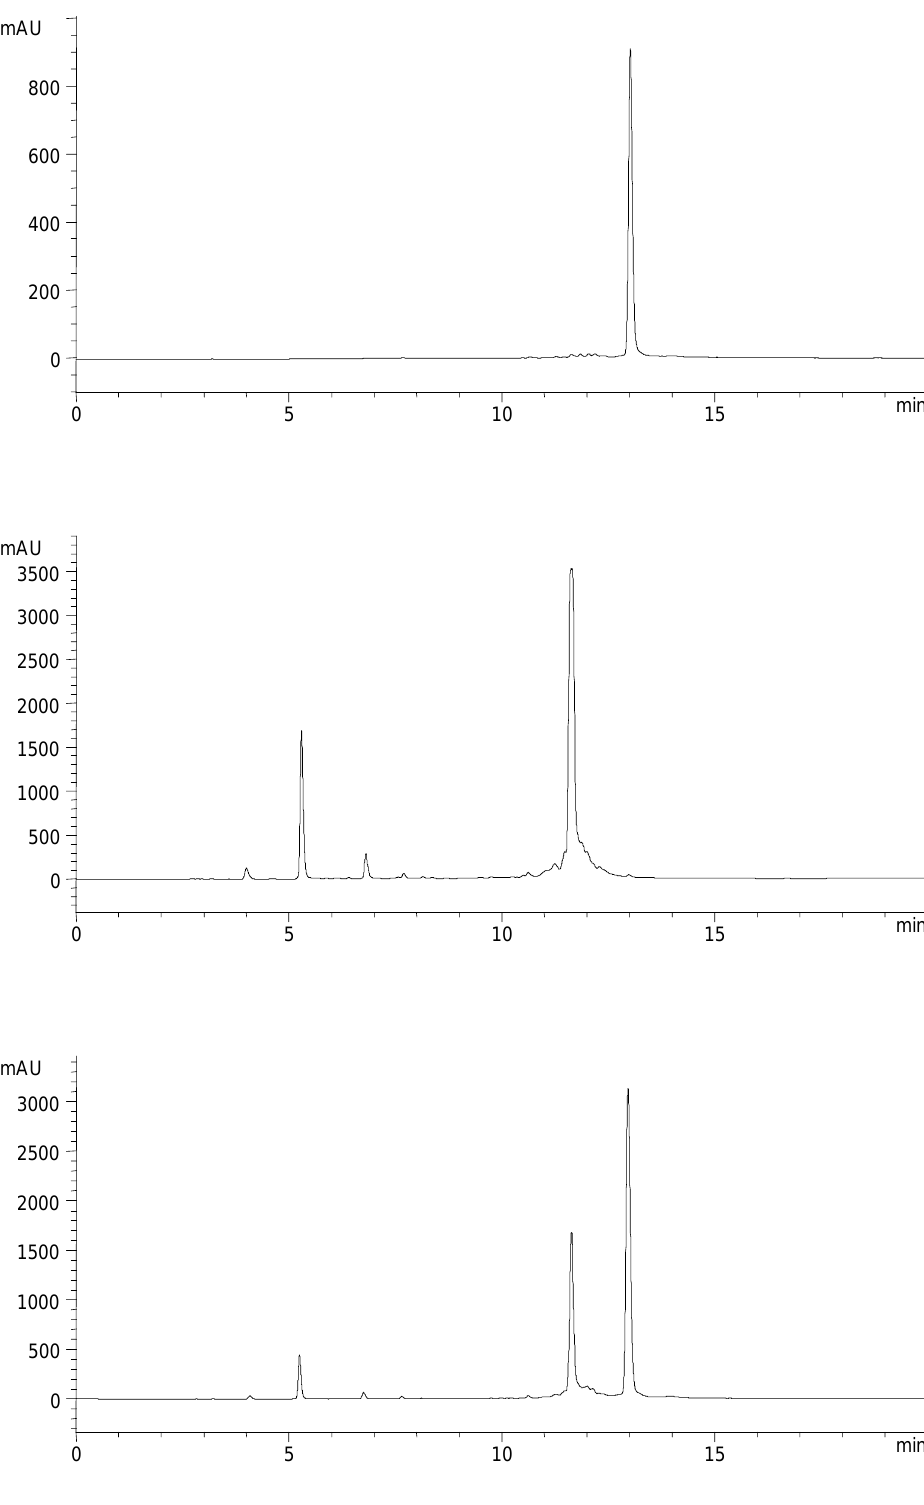
Figure 1. Reversed phase HPLC profiles of the target metronidazole oligonucleotide conjugate 5 with retention time 13.1 min (upper trace), aminoethyl oligonucleotide conjugate 4 with retention time 11.7 min (middle trace) and a co-injection of both conjugates 4 and 5 (lower trace). The vertical axes show milliabsorbance units (mAU) and the horizontal axes show retention